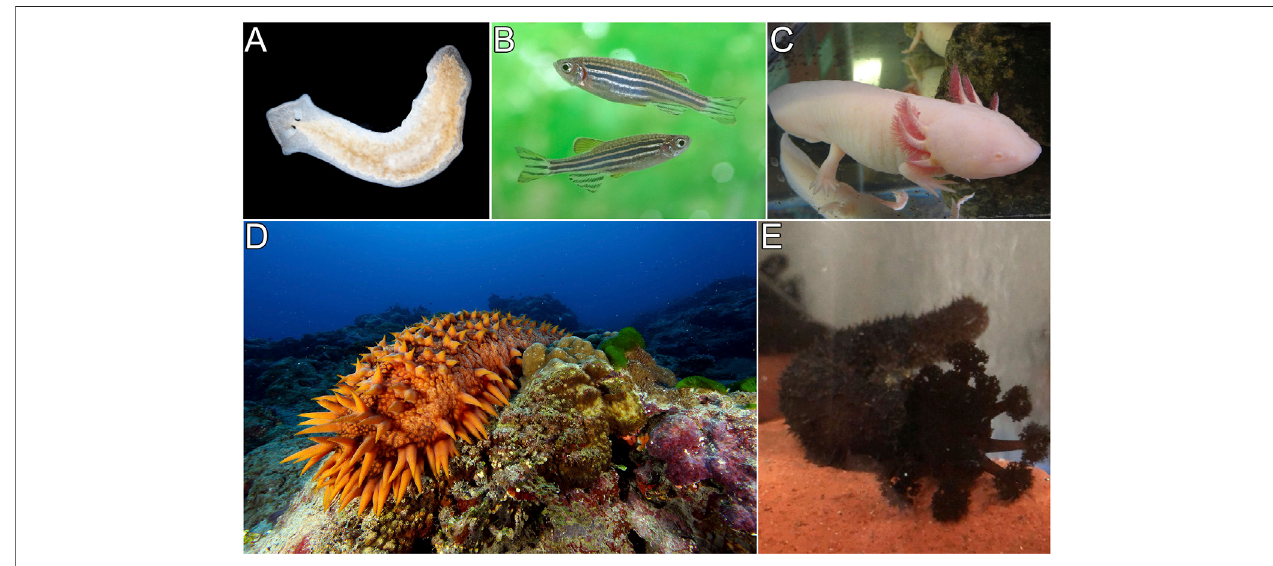
FIGURE 2 | Models of regeneration. This fi gure portrays organisms that are used as regeneration models: planaria (A) , zebra fi sh (B) , axolotl (C) , and two holothurian species, Apostichopus japonicus (D) and Holothuria glaberrima (E) .